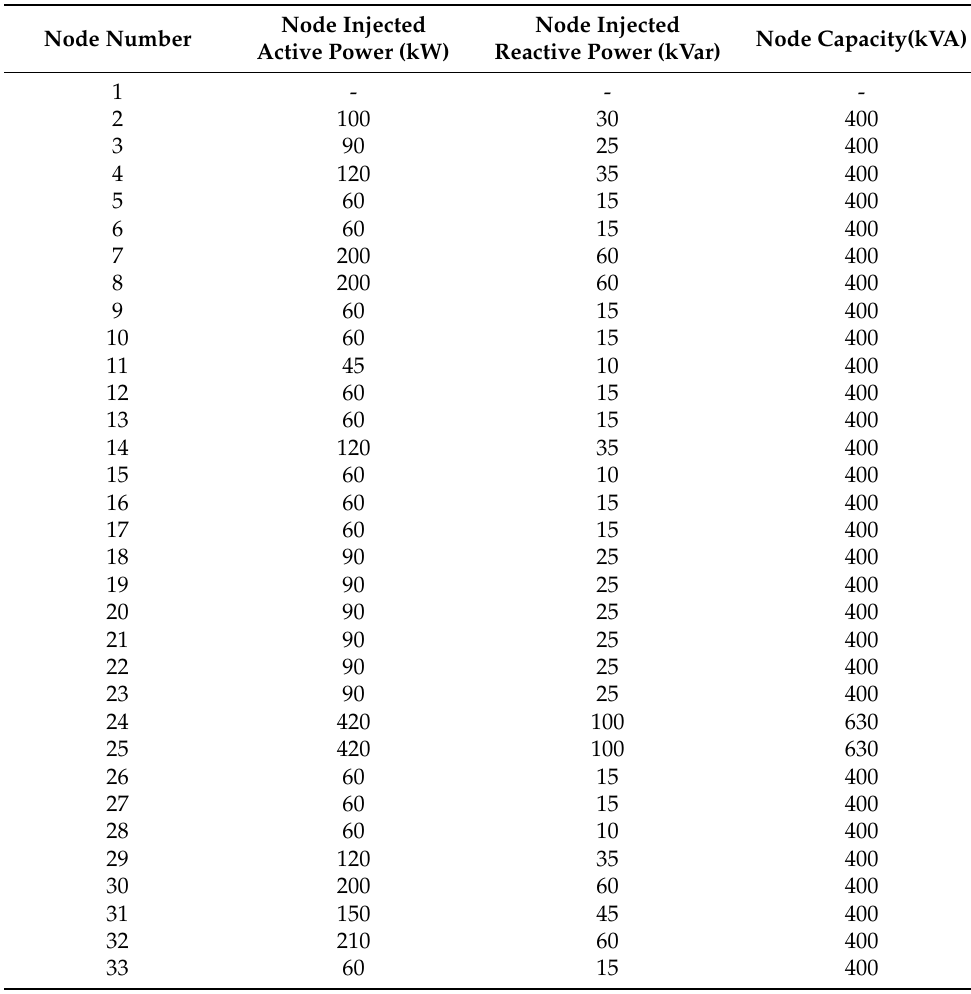
Table A1. Load parameters of IEEE-33 node power distribution